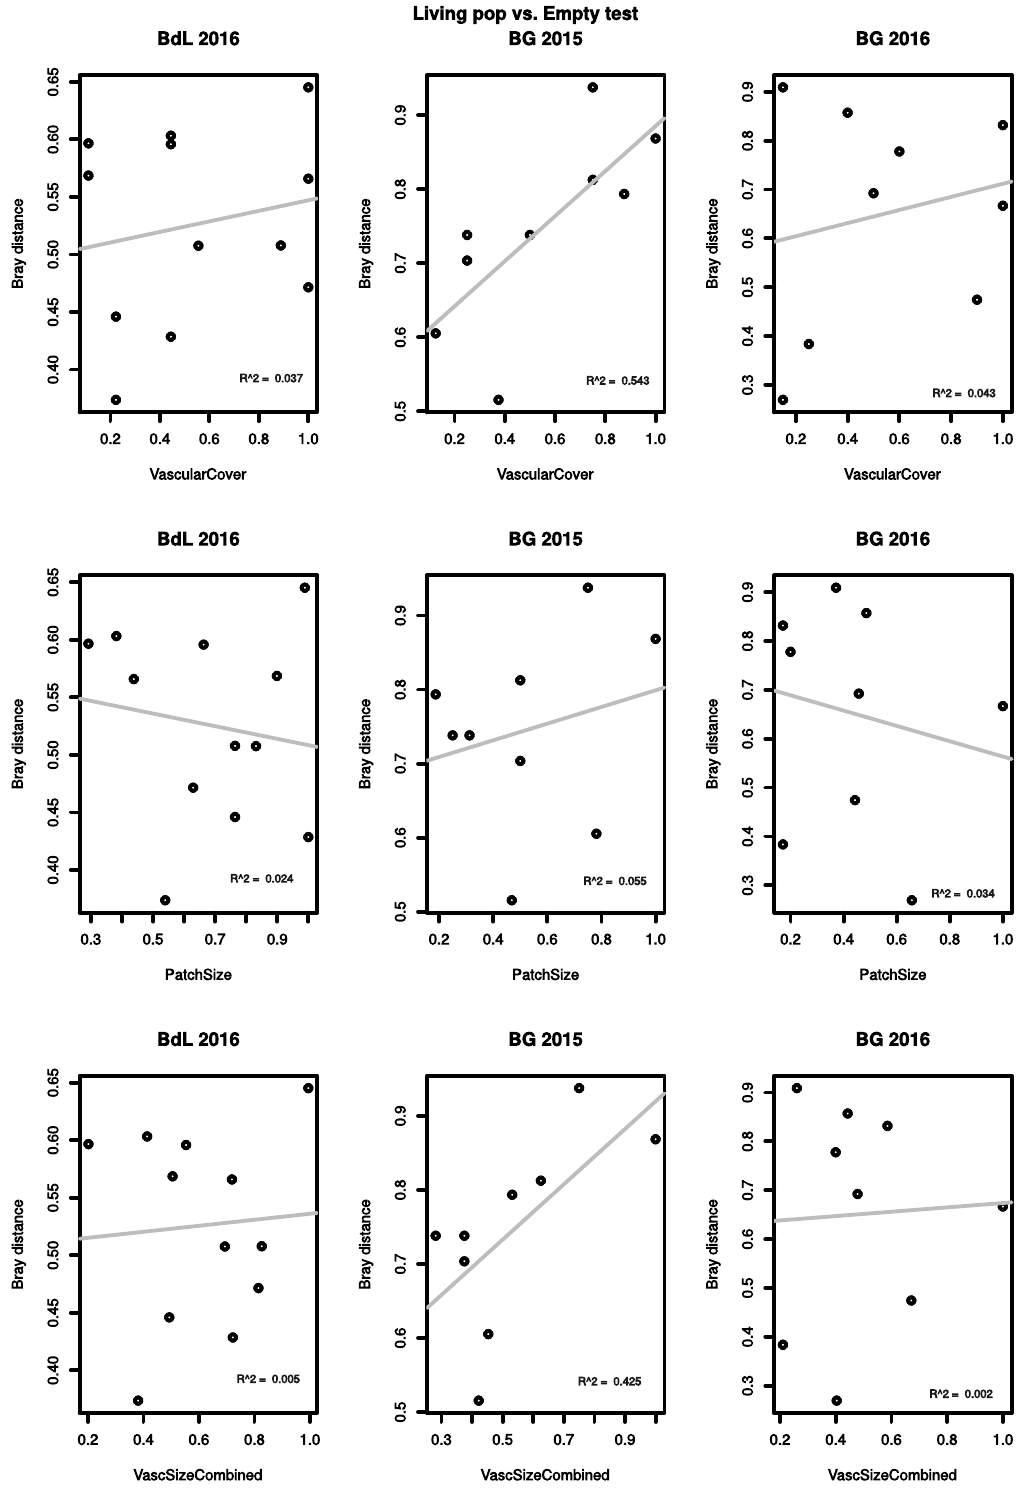
Figure 6: Biplots of β-diversity (Bray-Curtis distance index) calculated between living and dead testate amoeba assemblages from the Neuchâtel Botanic Garden experimental peatland (BG_2015, BG_2016) and the Bois-des-Lattes reference peatland (BdL) in relation to patch size, shading (% vascular plant cover) and a combination of the two, each given as a percentage of the maximum for the site. R^2 represents the linear regression coefficient for each